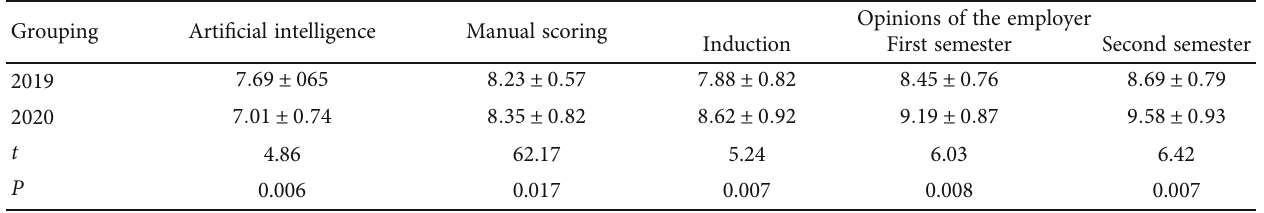
Table 3: Statistics of students ’ aerobic teaching scores (the data comes from the student fi les of the student o ffi ce of our university). Grouping Arti fi cial intelligence